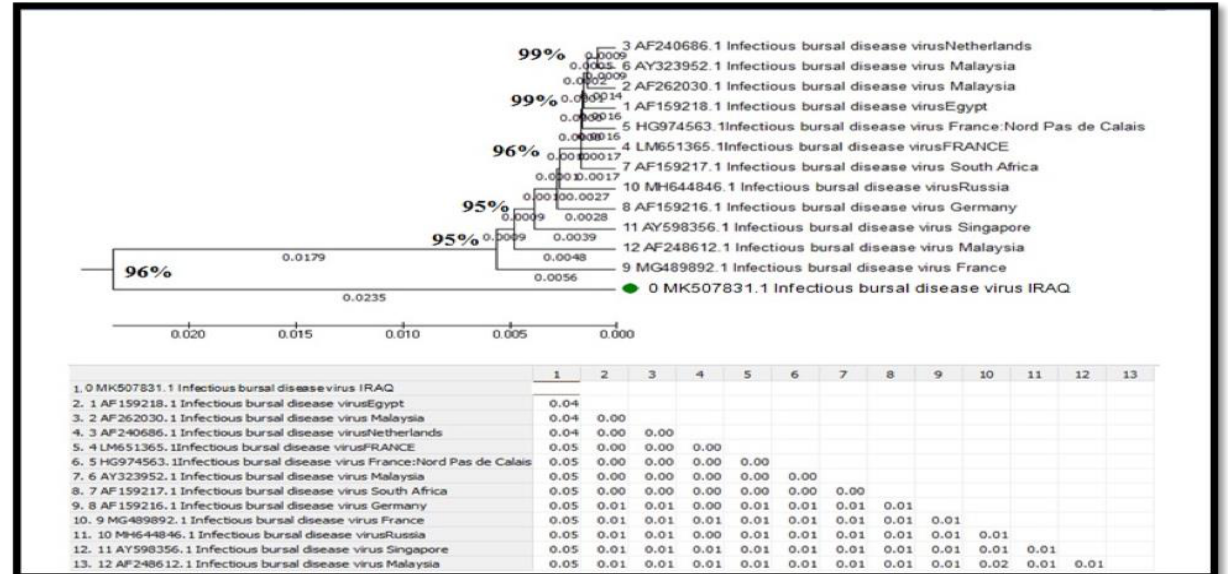
Figure 3. Phylogenetic tree of the VP2 gene of an Iraqi isolates submitted to NCBI under the accession number MK507831.1